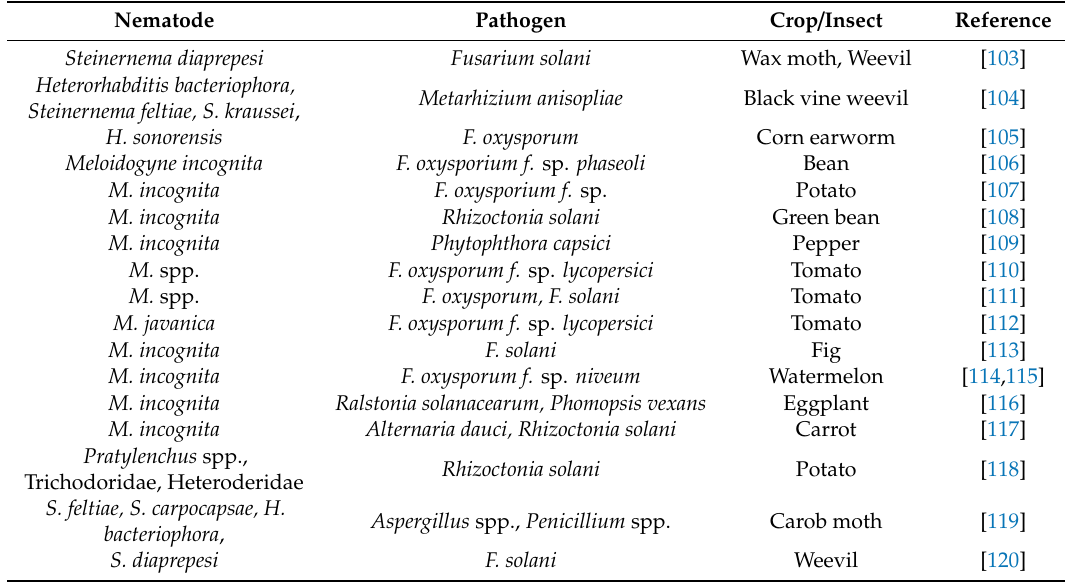
Table 2. Examples of nematode–pathogen disease complexes reported in crops and